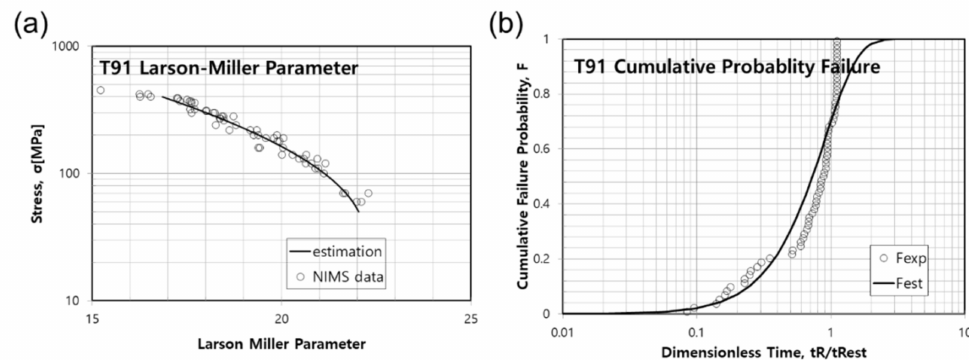
Figure 4. NRIM test results for creep life prediction: ( a ) Larson–Miller parameter, and ( b ) cumulative failure probability curve of P91